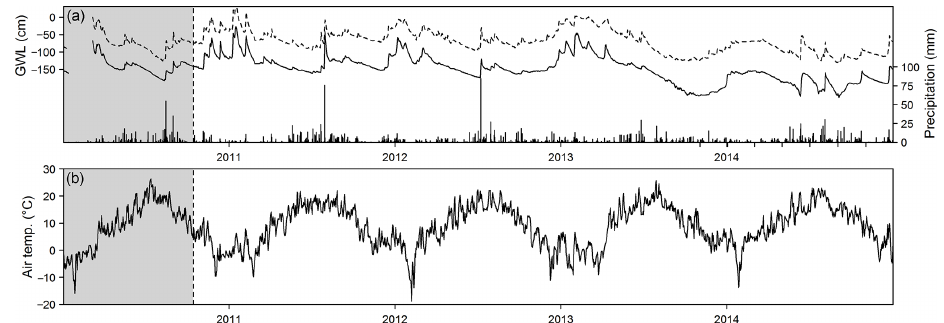
Figure A1. Time series of recorded environmental conditions throughout the study period from 2010 to 2014. Daily precipitation and GWL are shown for the upper (solid line) and lower (dashed line) chamber positions in the upper panel (a) . The lower panel (b) shows the mean daily air temperature. The gray shaded area represents the period prior to soil manipulation. The dashed vertical line indicates the soil